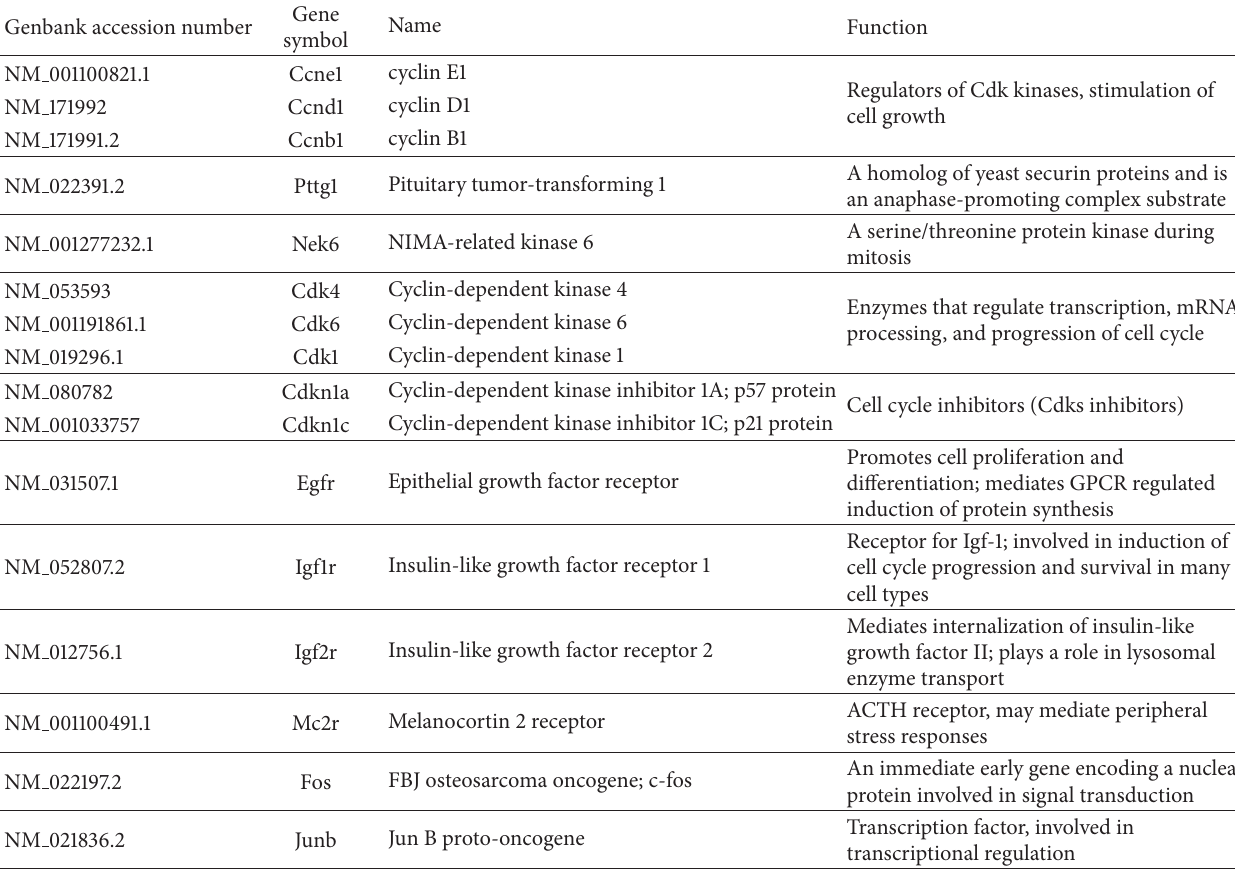
Table 1: List of genes whose profile expression during enucleation-induced rat adrenal regeneration was validated using QPCR method. Gene Name Genbank accession number symbol